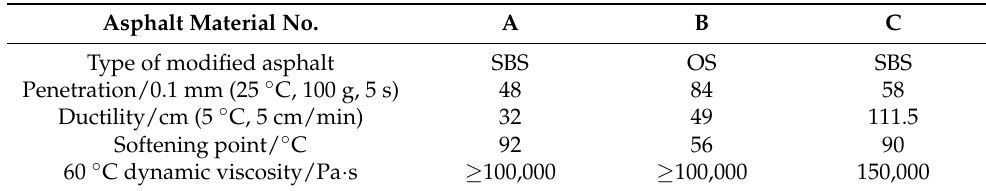
Table 2. Properties of the asphalt materials.